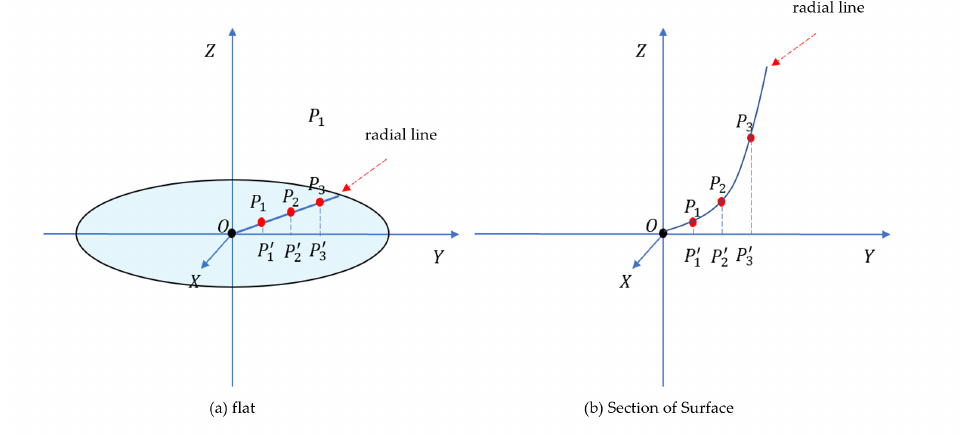
Figure 12. Schematic diagram of the distance between adjacent points in the radial direction, ( a ) radial line on plane, ( b ) radial lines on